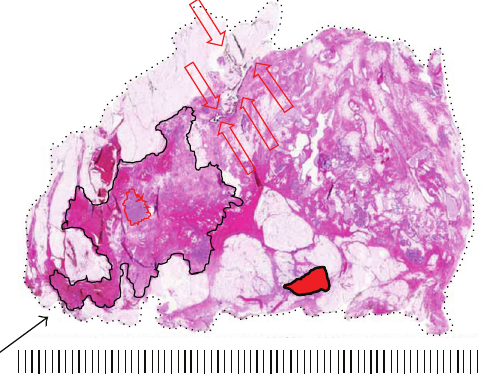
Figure 8: Large-format section of a lumpectomy specimen from a 72 year woman. India Ink migration into the interior of the specimen is marked with open red arrows. The true surgical margin is represented by broken black line. Grade 2 DCIS extending 35 m (solid black line) is present 2 mm from migrating ink. A small grade 1 invasive ductal carcinoma is outlined by a solid red line. A biopsy cavity is located lower-central (solid red fill). The biopsy was positive for DCIS. No residual DCIS was found within 12 mm of the biopsy site. The solid black arrow points to a positive surgical margin suspected on specimen radiograph which led to the submission of this section. Scale: small divisions = 1.0 mm (H&E).